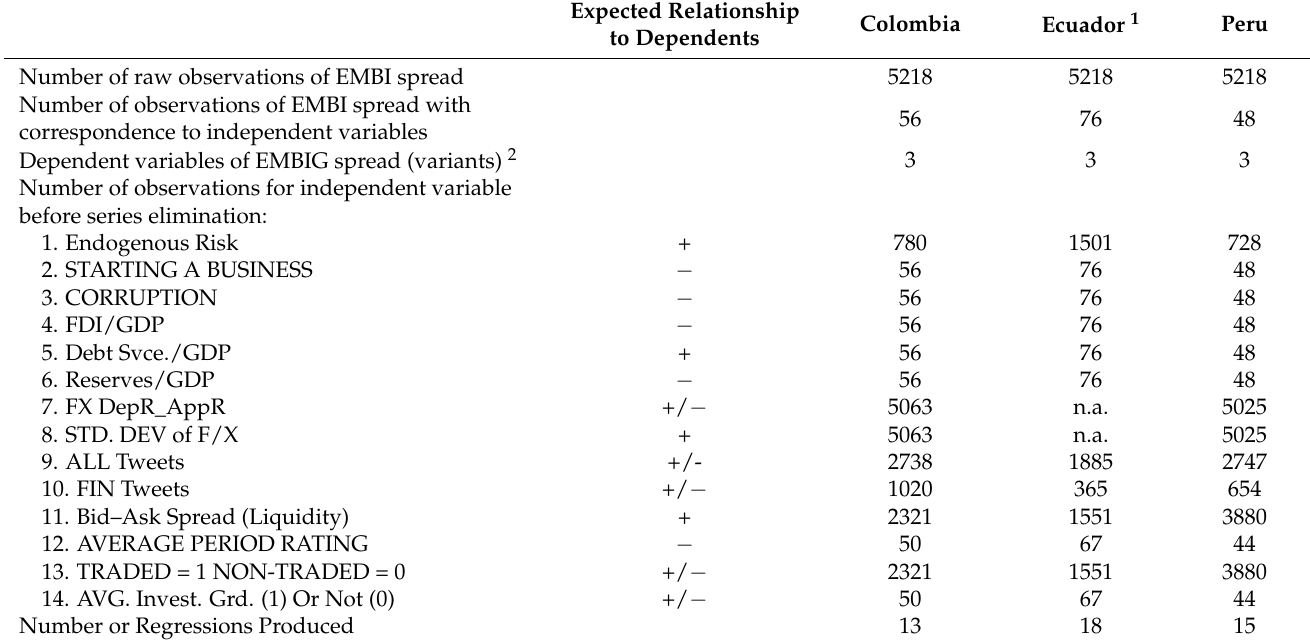
Table 5. General overview of empirical data